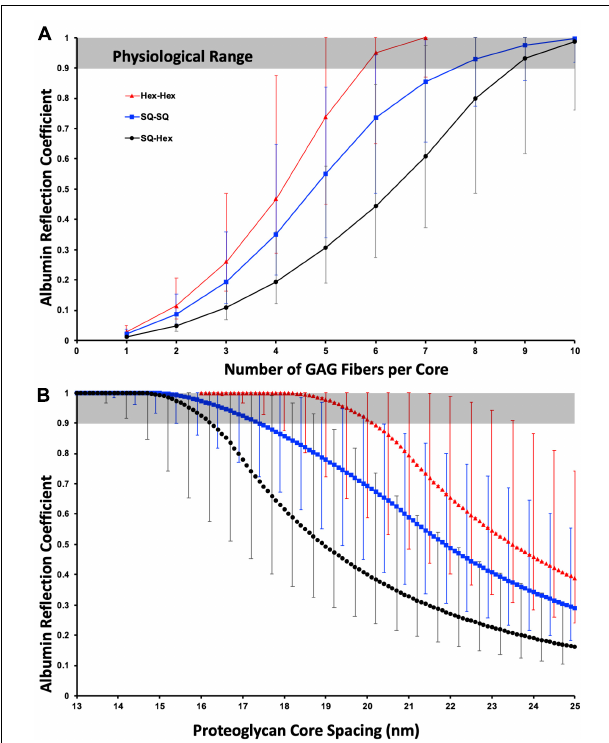
FIGURE 2 | The physiological albumin reflection coefficient fits well with a hexagonally packed dimerized PG core with a total of ≥ 6 GAG chains with a diameter of 1.5 nm (including charge effects). (A) Variation of reflection coefficient with the number of GAG chains per PG core structure. The data is depicted for hexagonal and square core organization (Hex- and SQ-, respectively) with the overlaying GAG chain organization hexagonal (Hex) or square (SQ). (B) As A but demonstrating the dependance of reflection coefficient on fiber spacing with six GAG chains per core structure. The physiological reflection coefficient is the grayed area. The error bars are for a 0.5 nm (lower reflection coefficient) and a 3 nm (higher reflection coefficient) fiber